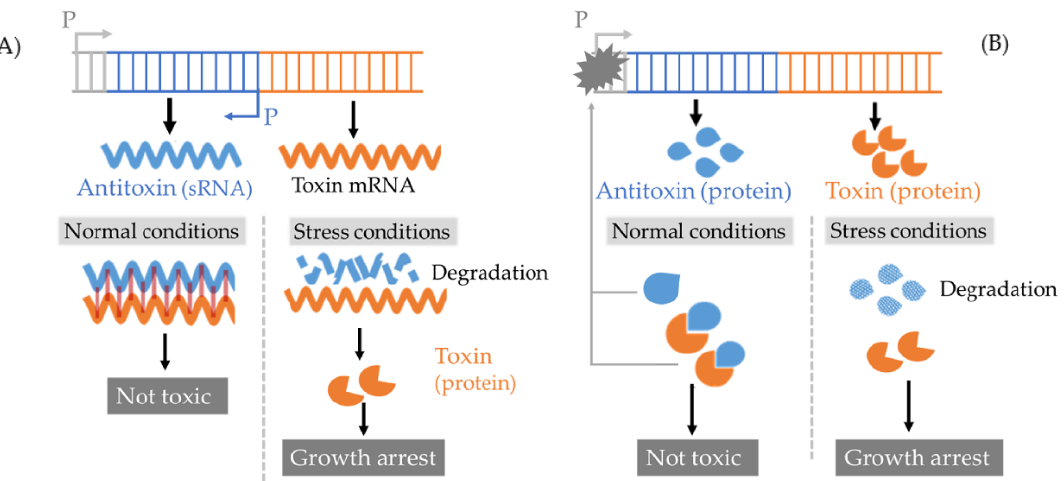
Figure 4. Models of Toxin-antitoxin (TA) systems associated with persister formation. ( A ) Type I TA system: it contains a small RNA (sRNA) antitoxin and a protein toxin. In normal conditions, antitoxin inhibits the translation of toxin mRNA. In a stress condition, the antitoxin is degraded, freeing the toxin mRNA to be translated. The type I toxin causes bacterial membrane depolarization. ( B ) Type II TA system: it contains a DNA-binding protein antitoxin and a protein toxin. In normal conditions, the antitoxin binds to the toxin and inhibits its activity. The antitoxin, as well as most of type II TA, the complex can target on the promoter and repress the transcription of the toxin gene. In stress conditions, the antitoxin is degraded by Lon or Clp proteases, releasing the toxin to inhibit several essential metabolic processes like DNA or protein synthesis. P: